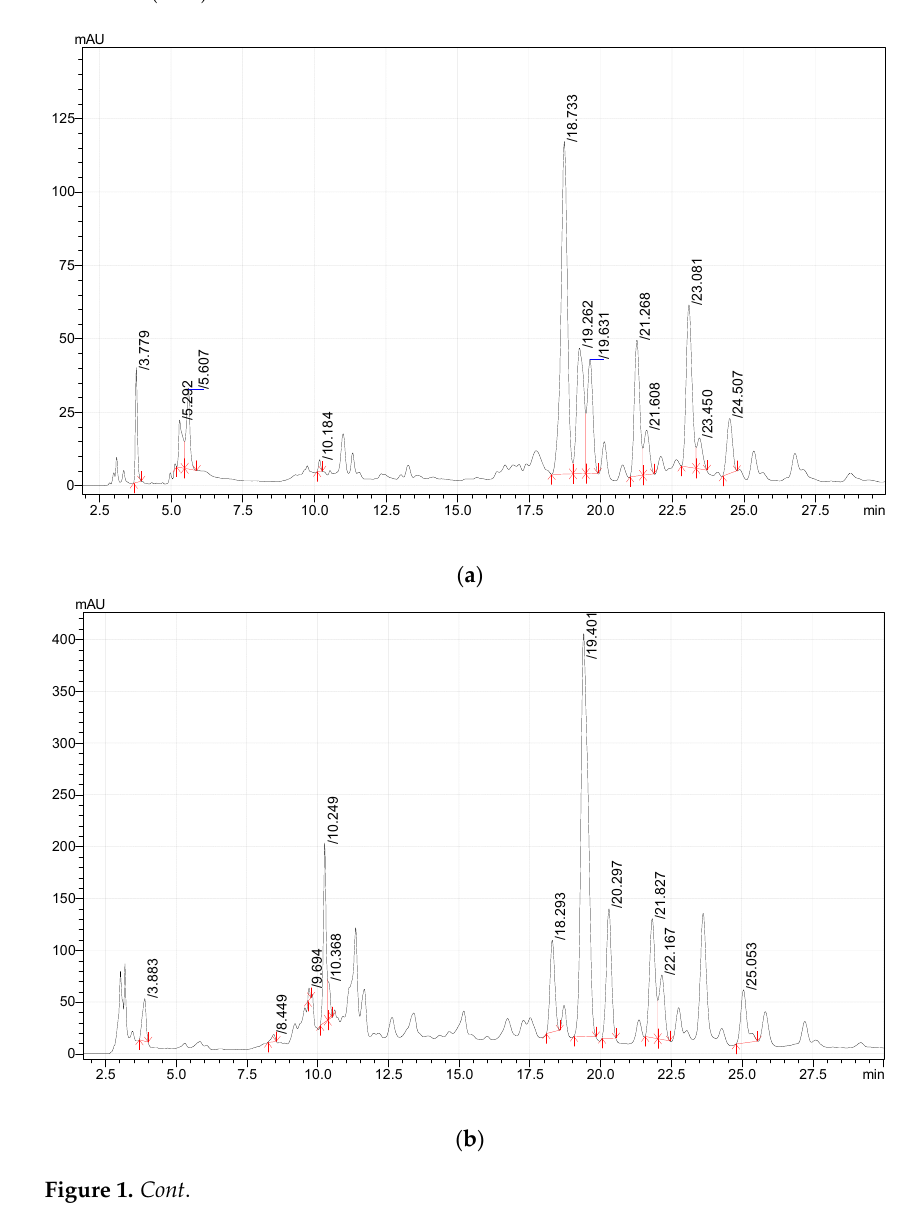
The analysis relied on RP-HPLC-UV with detection at 254 nm Values in row followed by the same letter a, b, c or d do not differ significantly ( p < 0.05) as assessed by the post hoc test (Duncan’s test). Data presented as a mean ± SD ( n = 3).